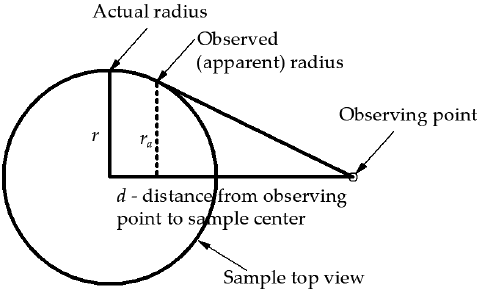
Figure 6. Schematic drawing (top view) of sample sidewall visibility problem.